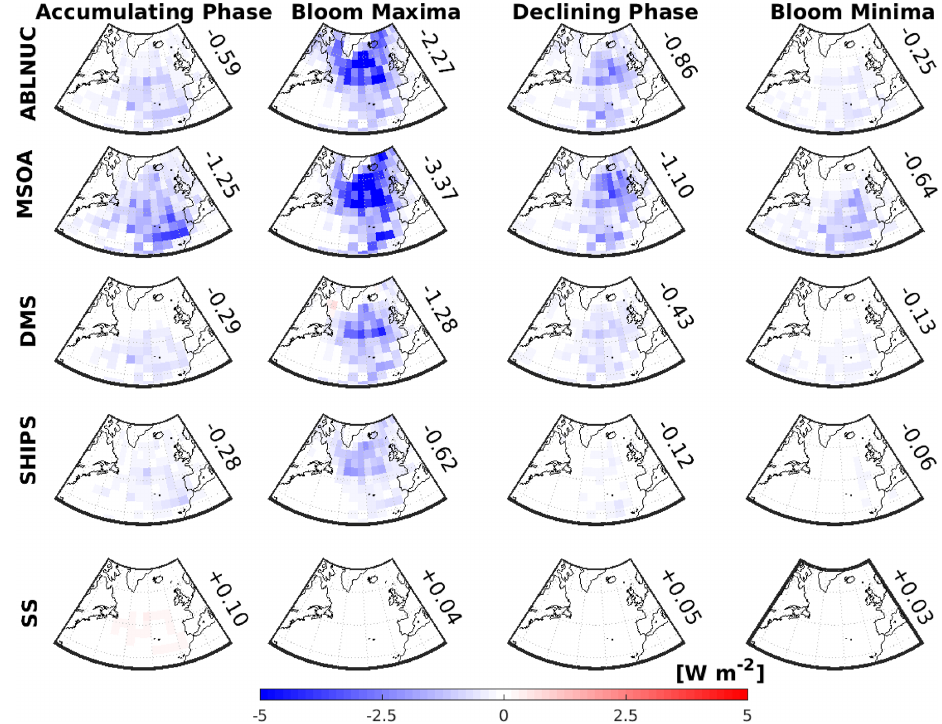
Figure 8. GEOS-Chem-TOMAS-simulated 2-month-mean cloud-albedo aerosol indirect effect (AIE) attributed to five key factors. Top row: above-boundary-layer particle nucleation (ABLNUC); second row: particle growth by marine secondary organic aerosol (MSOA); third row: particle formation and growth due to DMS-oxidation products (DMS); fourth row: shipping emissions contribution to particles (SHIPS); and bottom row: sea spray (SS). AIEs are in columns for the following time periods, March/April 2018 (Accumulating Phase), May/June 2016 (Climax Transition, Bloom Maxima), August/September 2017 (Declining Phase), and October/November 2015 (Winter Transition, Bloom Minima). AIEs for ABLNUC, MSOA, DMS, SHIPS, and SS are calculated using the differences in the top-of-the-atmosphere solar flux between simulation BASE and respective sensitivity simulations (noABLNUC, noMSOA, noDMS, noSHIPS, noSS). Values shown are area-weighted-mean AIEs over the region bounded by 40–60 ◦ N and 20–50 ◦